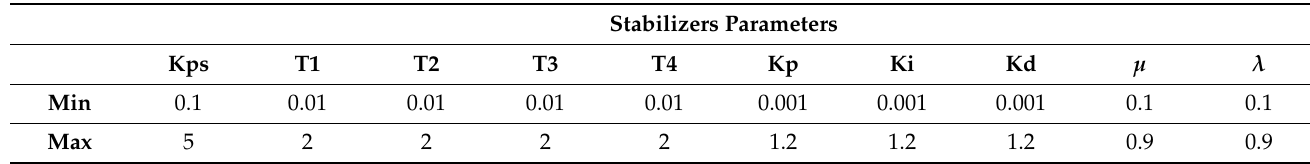
Table 2. A typical range of the stabilizer